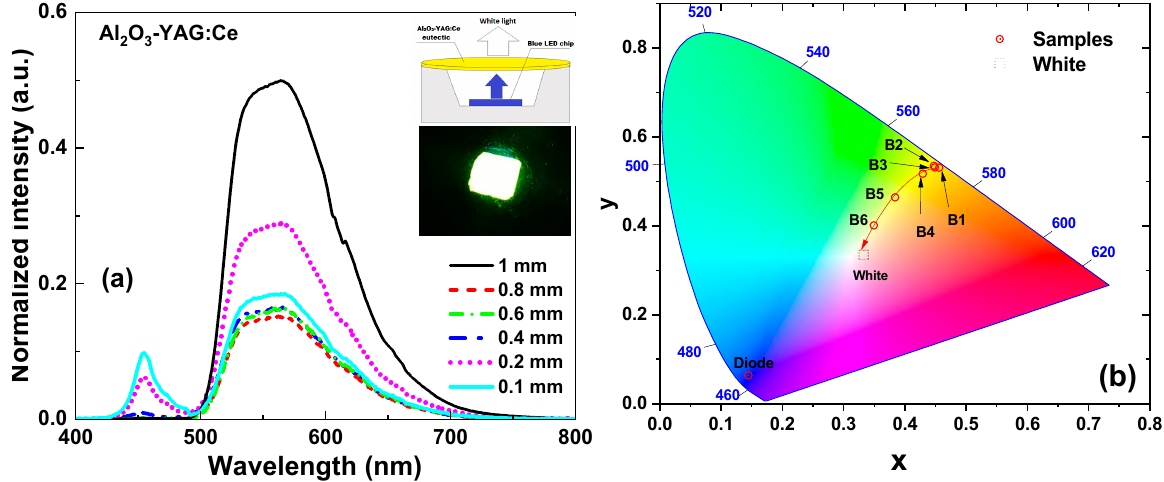
Table 3. CIE chromaticity coordinates, CTT and luminous e ffi ciency of a WLED lamp fabricated on the base of 450 nm LED chip and (Al 2 O 3 -YAG): Ce eutectic (sample 4) with di ff erent thicknesses. CIE Coordinates Thicknesses of Sample 4 h, mm